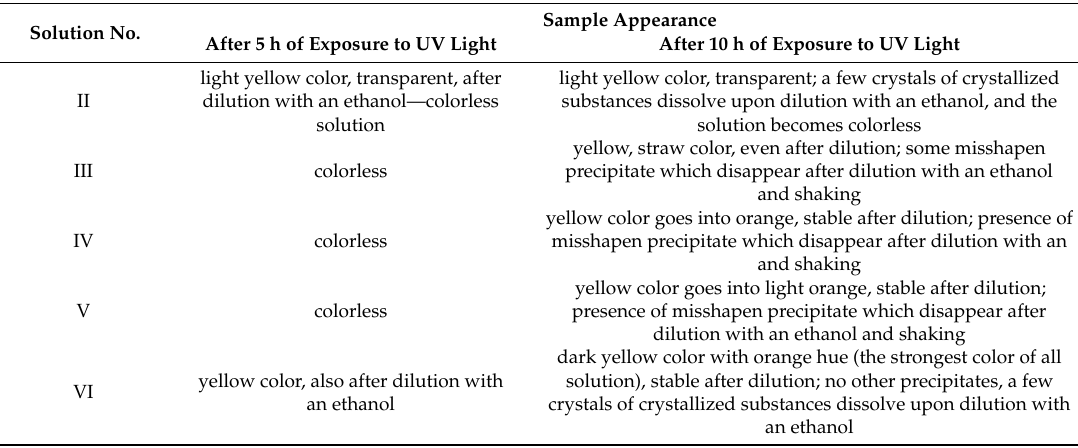
Table 1. Visible changes of naproxen solutions (II, III, IV, V, VI) observed after their irradiate to UV light (254 nm) during 5 and 10 h,